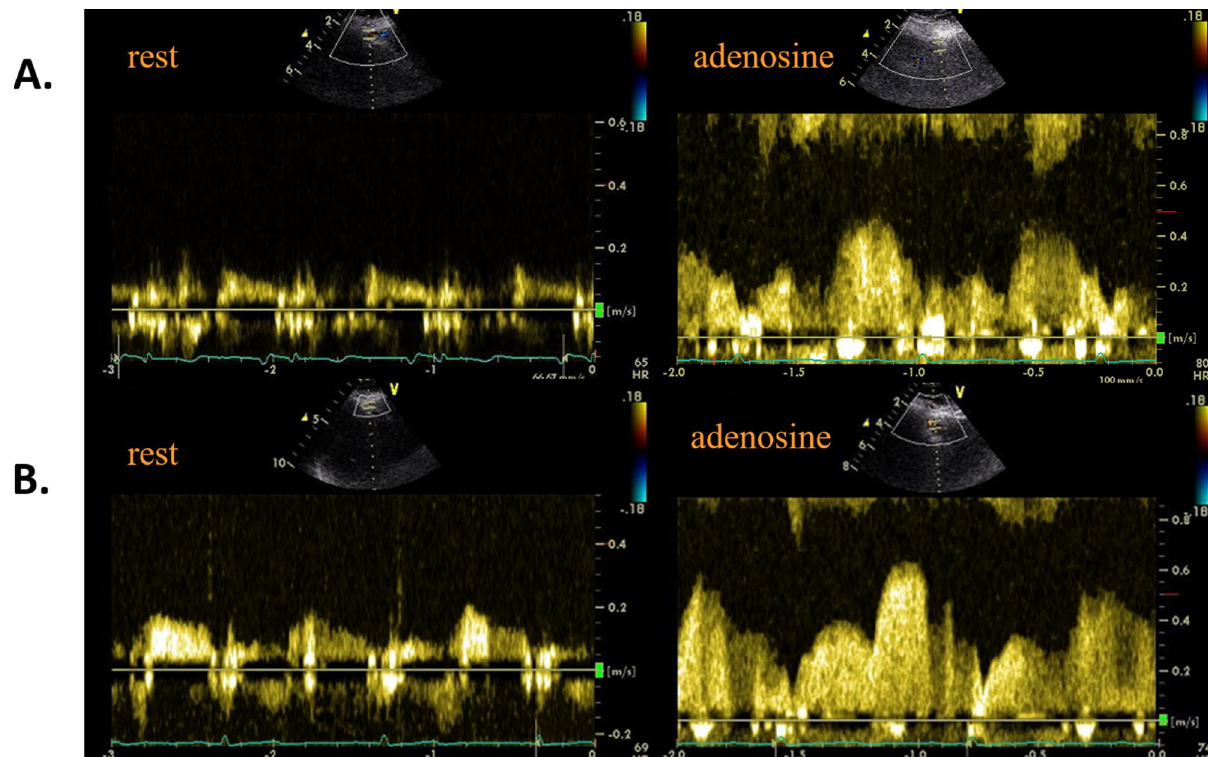
Figure 3. Coronary flow of left anterior descending artery at rest (left panel) and after adenosine infusion (right panel) for calculation of coronary flow reserve at baseline ( A ) and after switching to HNBC for one month ( B ). The coronary flow reserve increased from 2.5 to 3.1 after 1 month of switching from tobacco cigarette to HNBC.